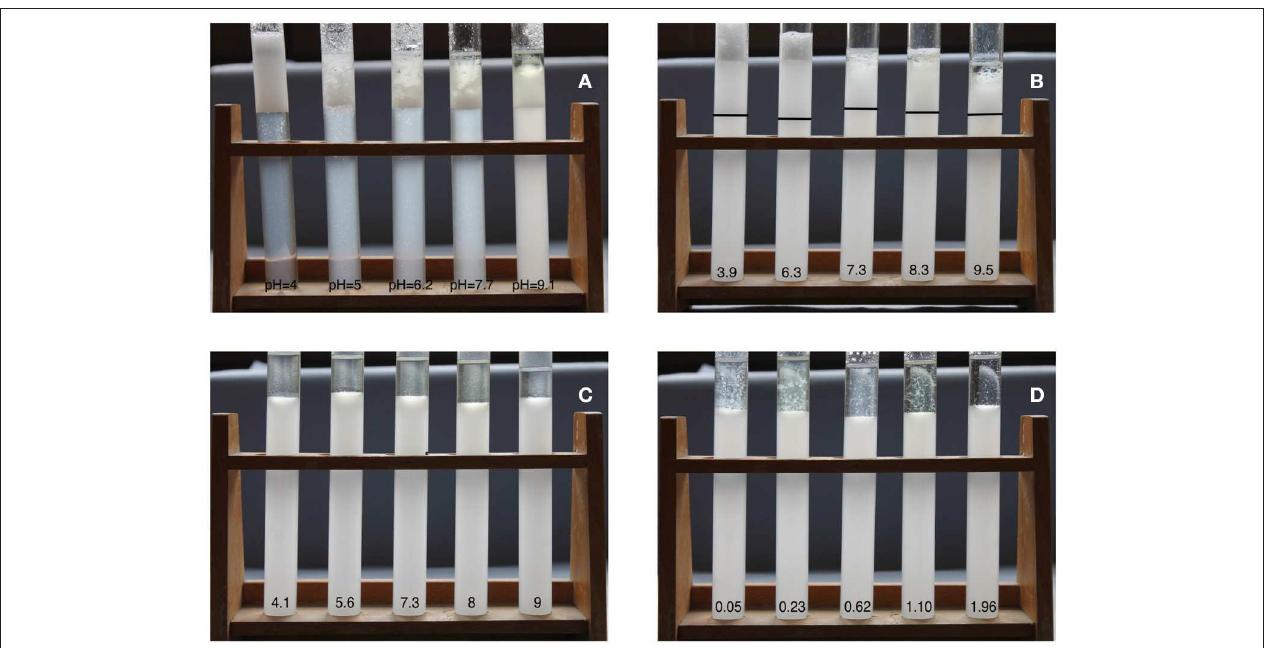
FIGURE 4 | Pictures of the phase transfer experiments. (A) 0.5 mM AlCl 3 with 2 mM SDS, (B) ZnCl 2 with 2 mM SDS, (C) 0.5 mM CaCl 2 with 2 mM SDS and (D) 11 µ mol AlCl 3 at pH = 4.6 with different SDS concentrations. pH values in (A–C) are indicated and the SDS concentration in (D) is given in